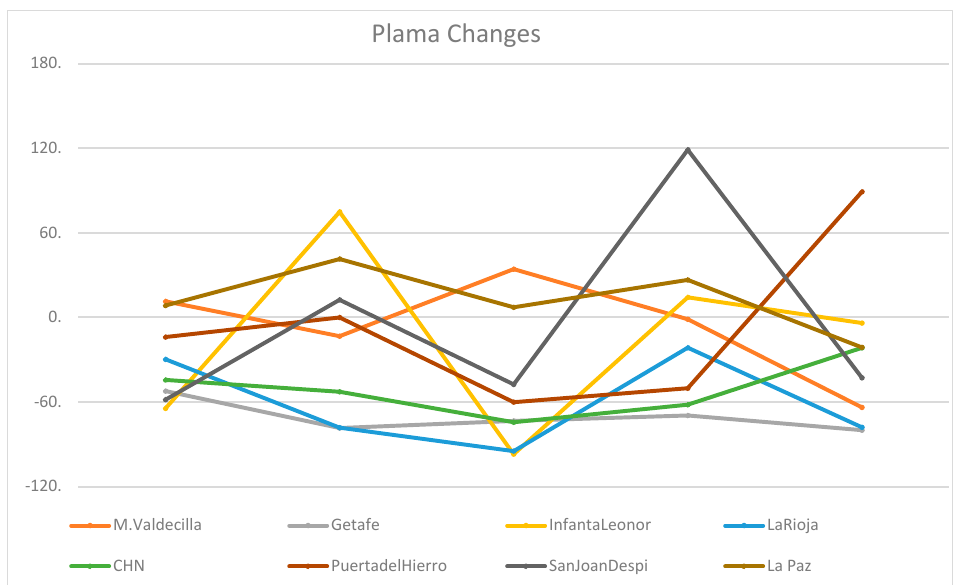
Figure A2. Platelets (excluding Hospital Infanta Leonor due to an “outlier” result of an increase of 310% in Period 0).